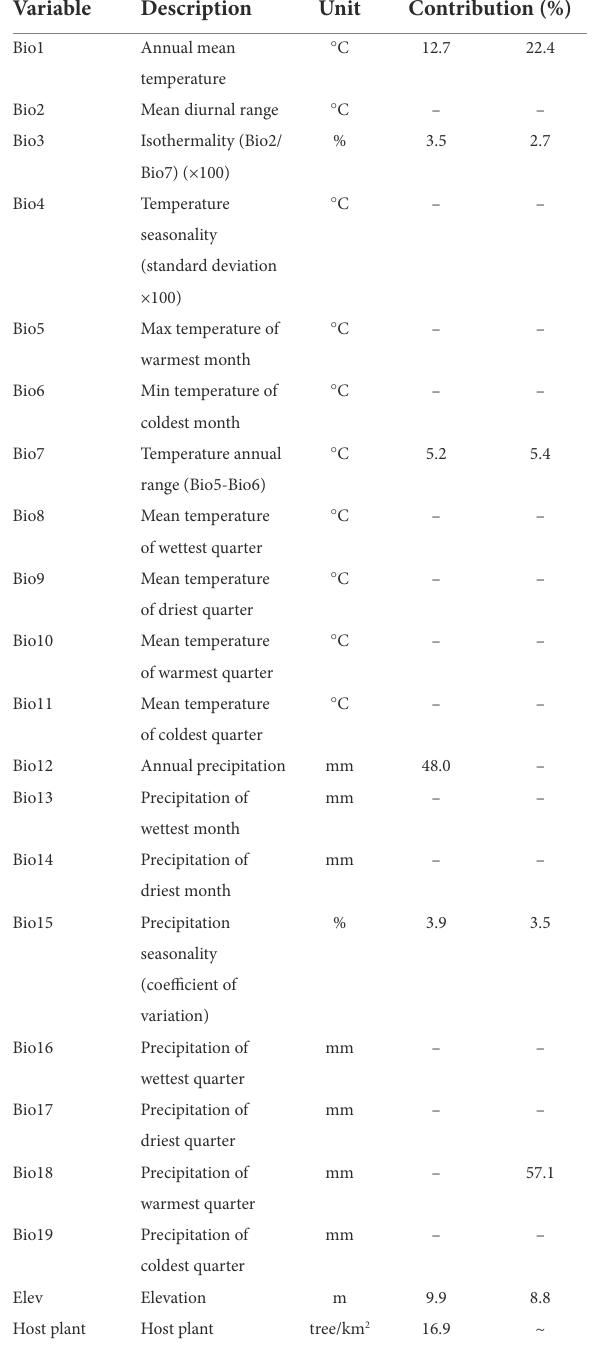
TABLE 1 Environmental variables used for modeling the current distribution of Sanghuangporus and their contributions to the predicted